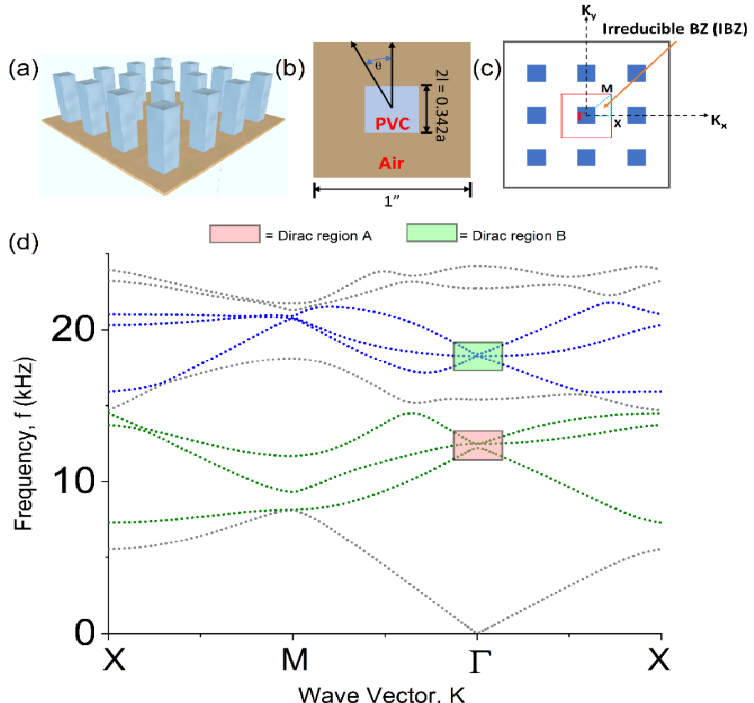
Figure 1. ( a ) Schematic representation of the two-dimensional periodic systems of hard square rods in a square lattice. The filling fraction is 0.1169 and the square array has the same orientation as the lattice, ( b ) Schematic view of the cross-section of the proposed PnC, composed of PVC having side, 2l = 0.342a hosted in air media, ( c ) transverse cross-section of the 2D square lattice of 3 × 3 supercell showing the irreducible Brillouin zone ( Γ MX), two constituents are denoted by white and blue as air and PVC rods, respectively, ( d ) Acoustic band structure for PVC square rods of filling fraction, F = 0.1169 embedded in air host, rotational angle is θ = 0°. The colored regions along Γ denote probable Dirac region A and Dirac region B, having bands colored in green and blue, respectively.